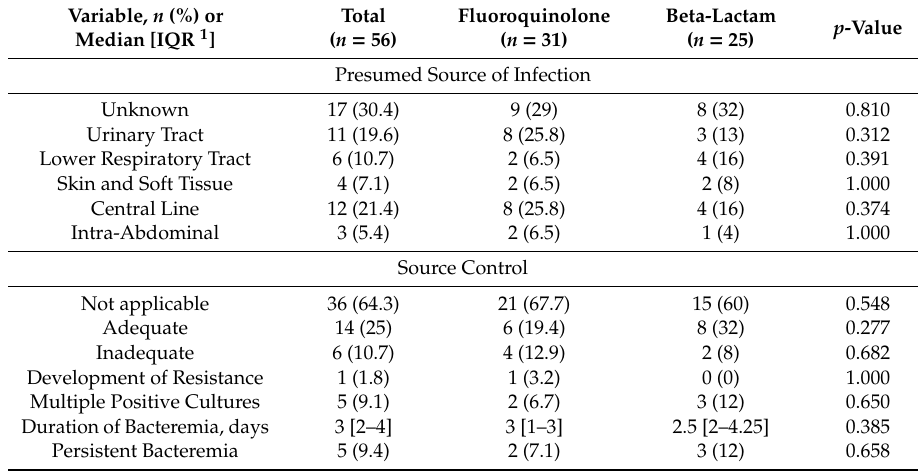
Table 2. Infection and Microbiological Characteristics of Patients Receiving Fluoroquinolone versus Beta-Lactam Definitive Therapy for CAE Bloodstream